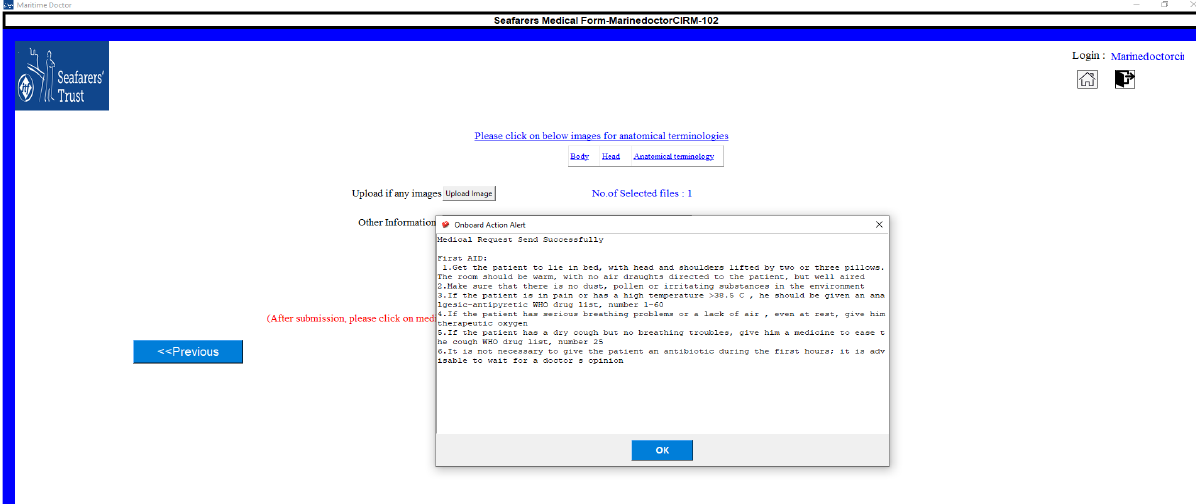
Figure 7. First aid display.